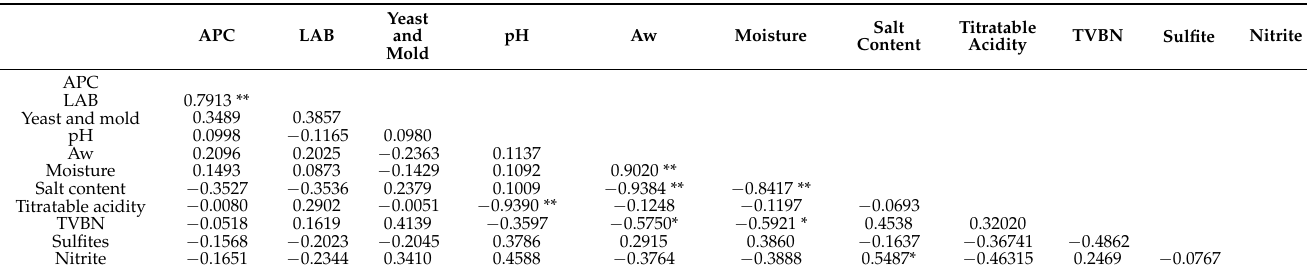
Table 4. Correlation coefficients among aerobic plate count (APC), lactic acid bacteria count (LAB), yeast and mold, pH, water activity (Aw), moisture, salt content, titratable acidity, total volatile basic nitrogen (TVBN), and sulfite and nitrite contents in mustard pickle products from retail market. LAB pH Aw Moisture Salt Content Titratable Acidity TVBN Sulfite Mold